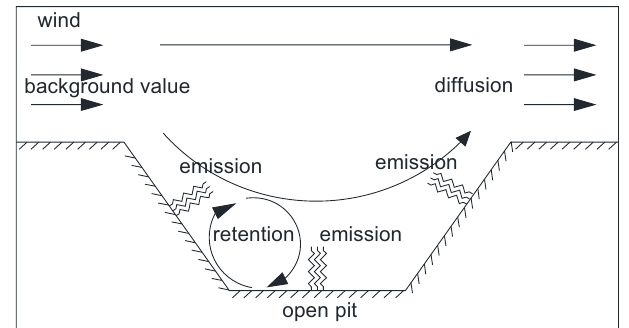
Figure 1. Dust diffusion process in open pit mine.